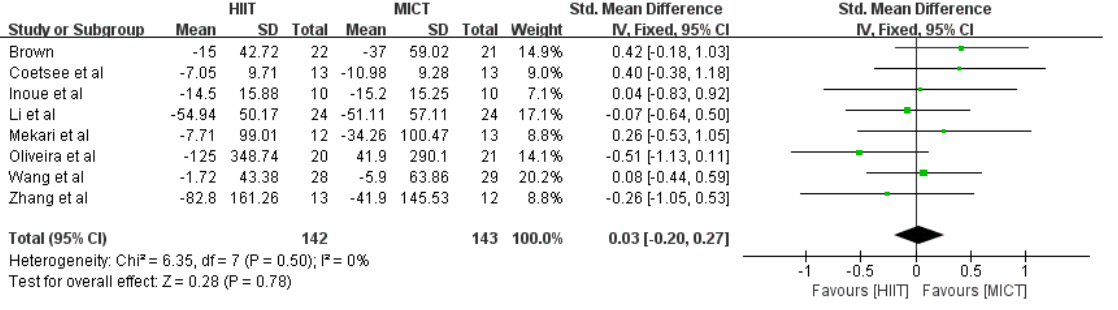
Figure 4. Effect of HIIT and MICT interventions on response time [24,25,31-36].